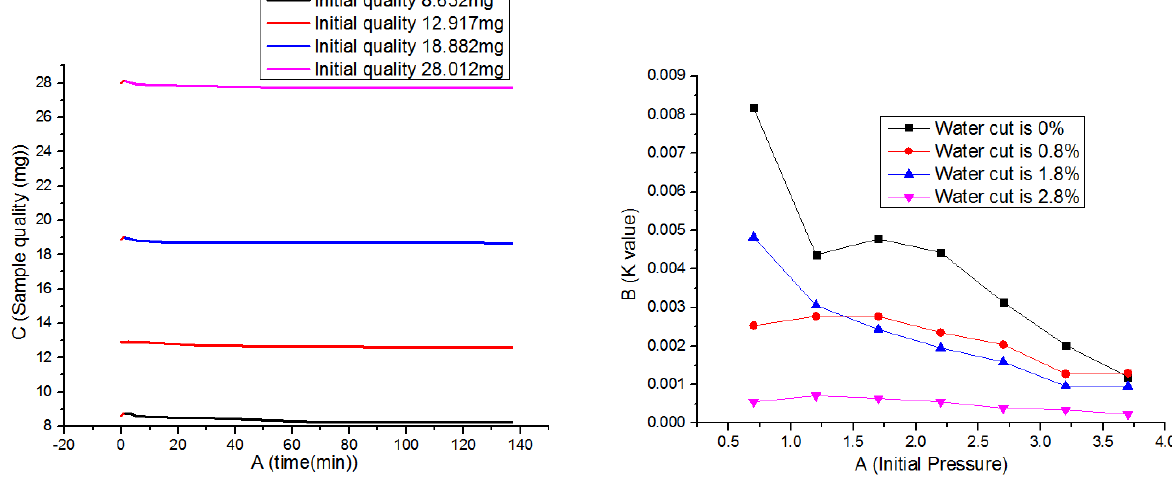
Figure 4 - Quality loss diagram of the thermogravimetric method.